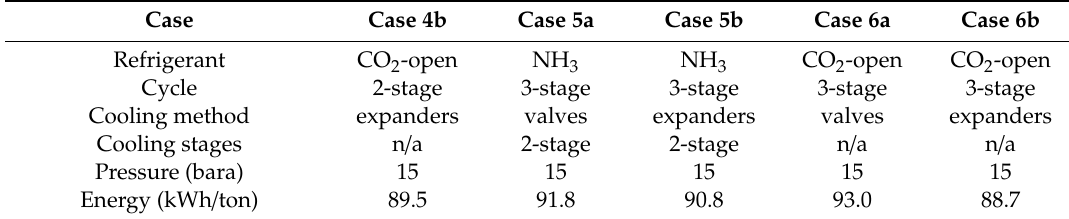
Table 4. Summary of optimized power consumption for the new process